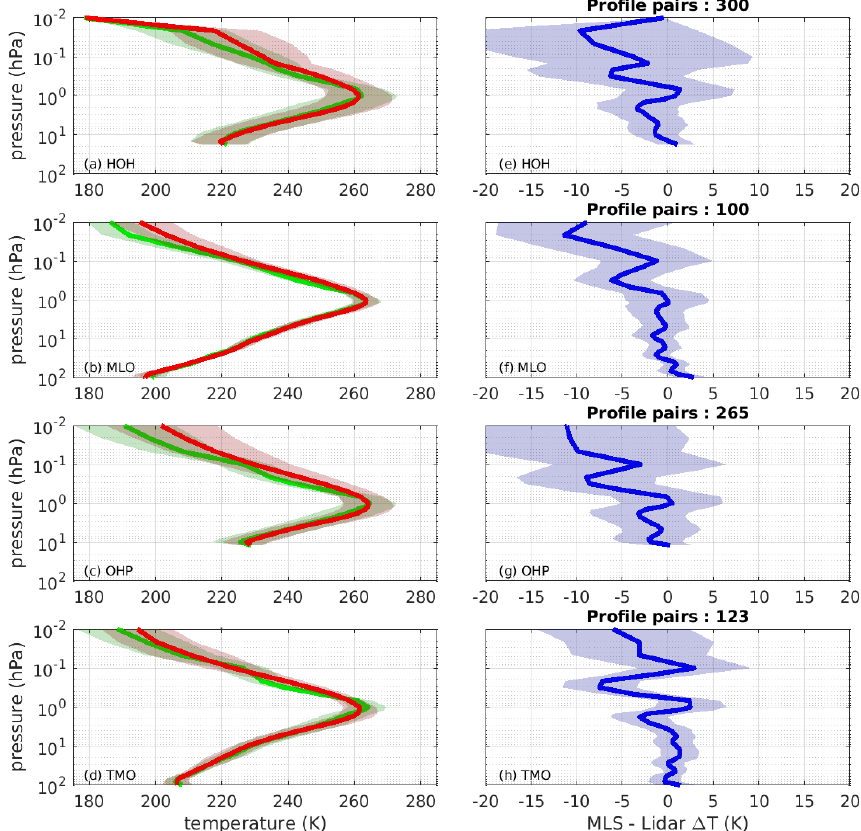
Figure 1. Mean profiles of both temperature from EOS MLS (green) and Rayleigh temperature lidar (red) positioned at (a) Hohenpeissenberg, (b) Mauna Loa, (c) Observatoire de Haute-Provence and (d) Table Mountain Observatory. Shading depicts 1 standard deviation in the mean temperature. The vertical profiles of the mean of the differences between the lidar and MLS for the lidar shown in (a–b) are shown in (c–d) respectively; shading shows 1 standard deviation within the mean